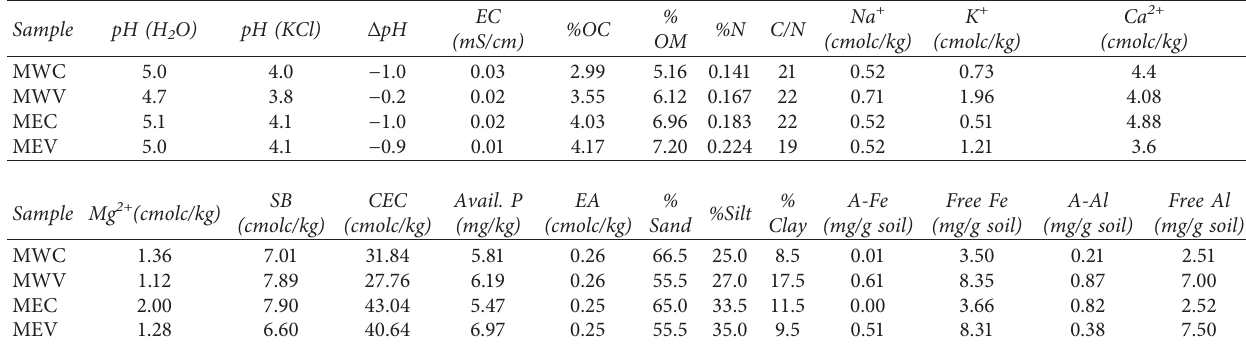
Table 1: Selected physicochemical properties of the soils.